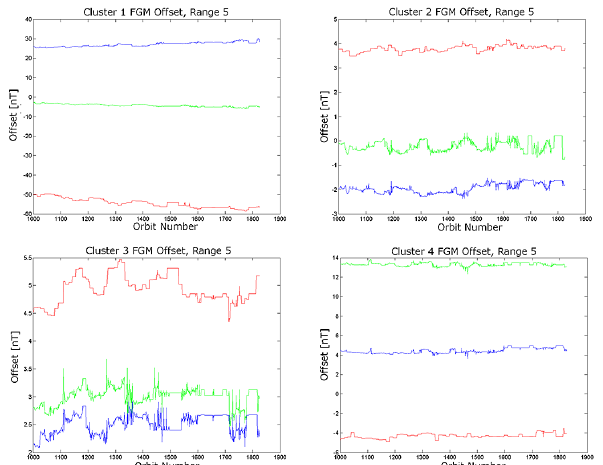
Figure 7. Range 5 spin-axis ( O 1 , red) and spin-plane ( O 2 and O 3 , blue and green) offsets in nanoteslas for orbits 1000–1812 (Decem- ber 2006–February 2012).